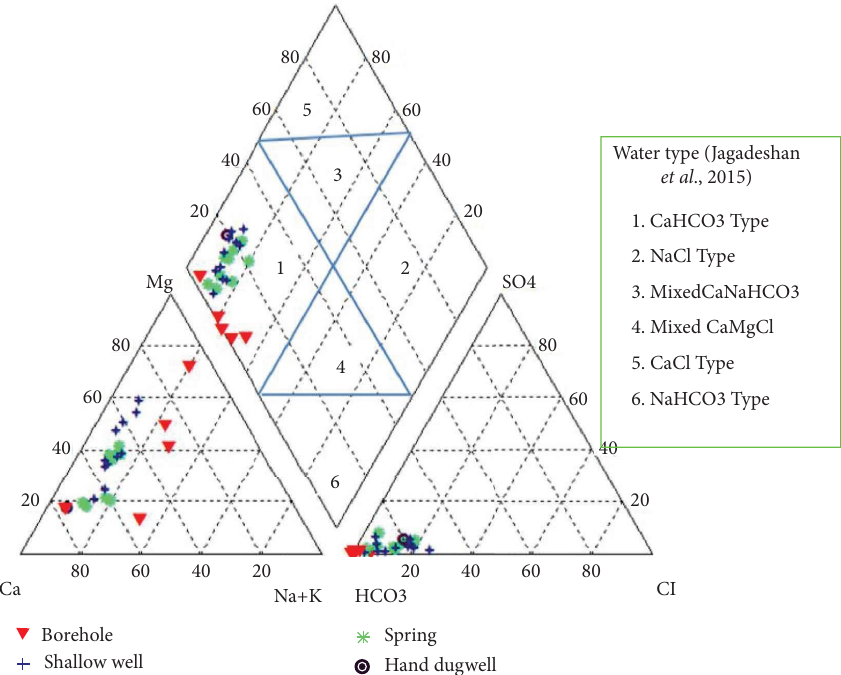
Figure 16: Piper trilinear diagram representation of major ionic (in percent of meq/l) data.